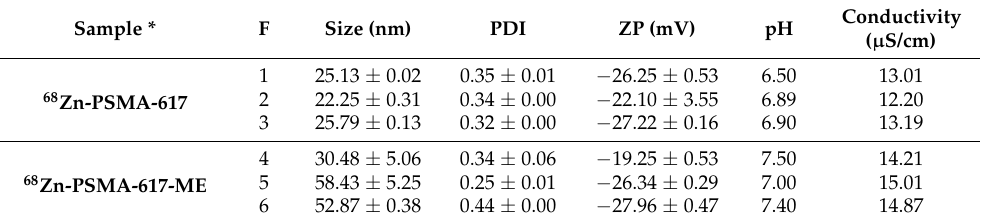
Table 1. Physicochemical characteristics of formulations used in animal